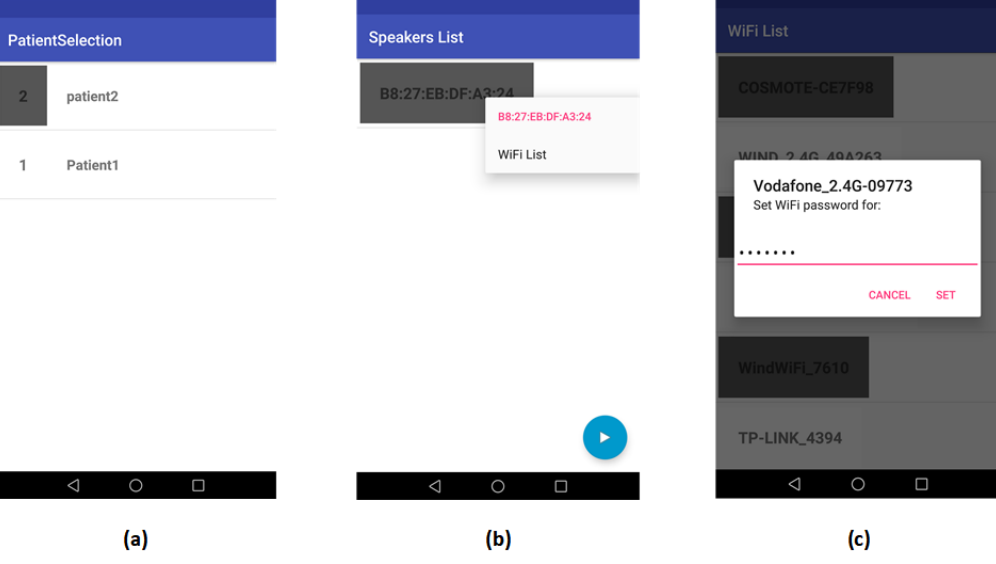
Figure 9. ( a ) Select associated sufferer; ( b ) manage smart speaker; and ( c ) set Wi-Fi connection for the smart